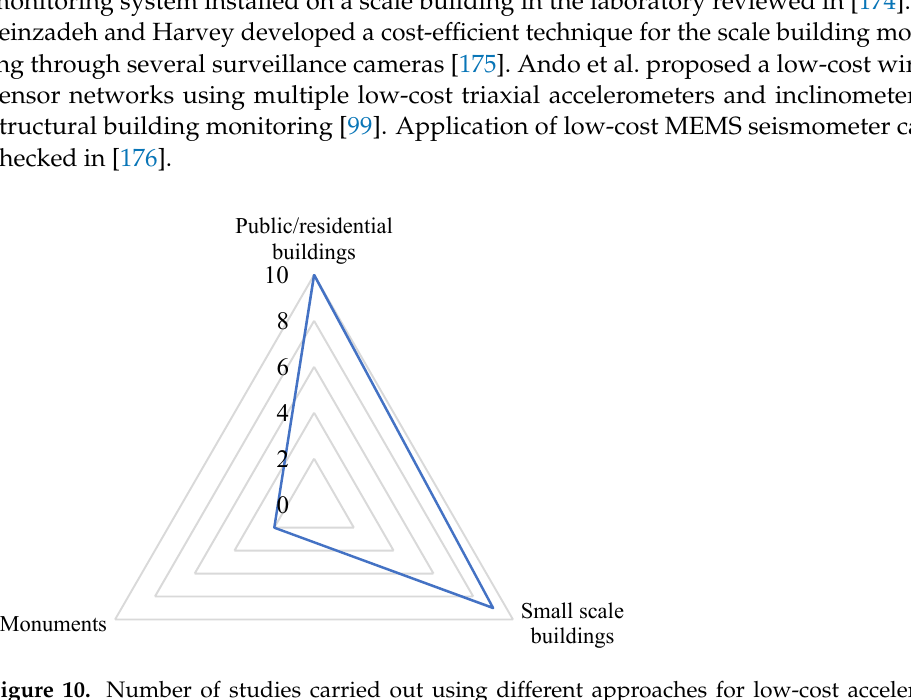
Figure 10. Number of studies carried out using different approaches for low-cost acceleration monitoring in buildings.